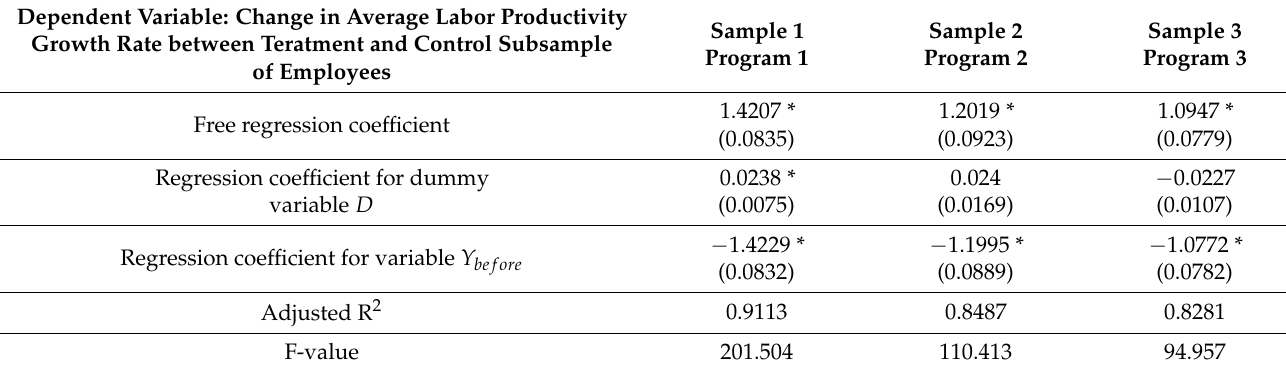
Table 6. Estimated parameters for model